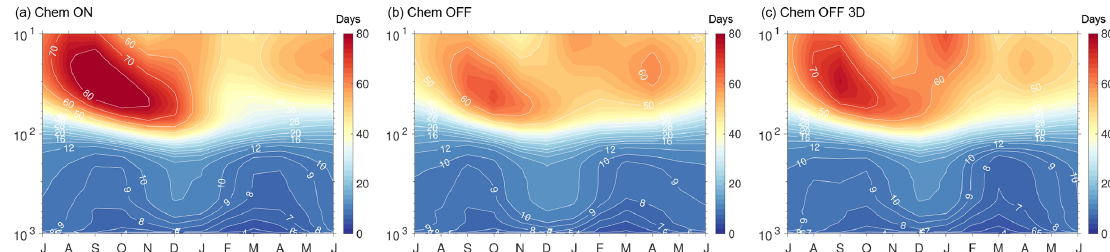
Figure 11. SAM timescale in days for the time period 1955–2013 for the (a) Chem ON, (b) Chem OFF and (c) Chem OFF3D